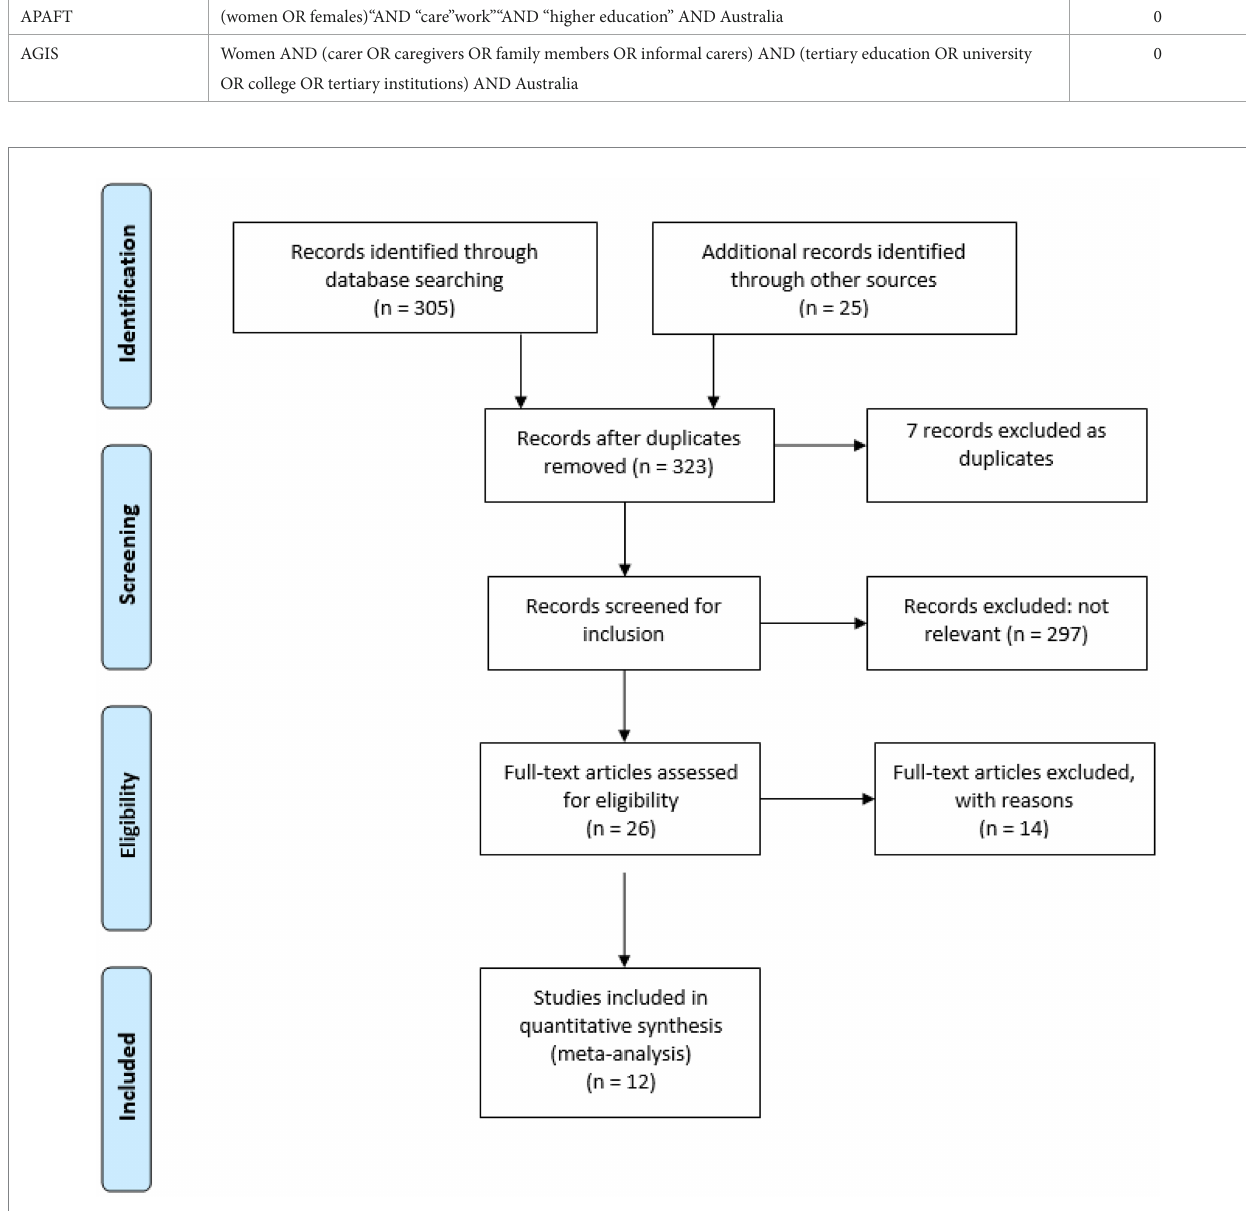
FIGURE 1 PRISMA flowchart of study selection